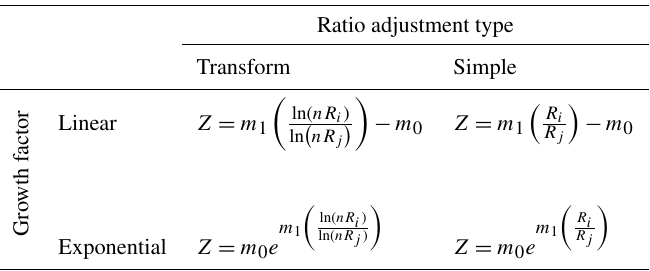
Figure 3. Sediment is detected in RGB Landsat imagery (acquired 5 August 2016) of a representative study lake (a, b) . This is confirmed as a temporary sediment plume by comparing the image of the lake used in modeling to 2.5m color-infrared photography acquired on 18 July 2002 (c) and a Landsat image acquired on 13 July 2016 (d) in which no sediment plumes are visible. Landsat-8 images and digital orthophoto quadrangles (DOQs) are courtesy of the US Geological Survey. Table 2. Equations for modeling depth. Modeled depth ( Z ) is calculated with each of four equations that are tuned with each of three input band pairs. R i and R j represent the top-of-atmosphere reflectances of bands i and j , respectively. Band pairs (band i and band j ) include the blue and red bands, the blue and green bands, and the green and red bands. Tunable parameters m 1 and m 0 are derived by comparing spectral signatures with depth (as in Fig.